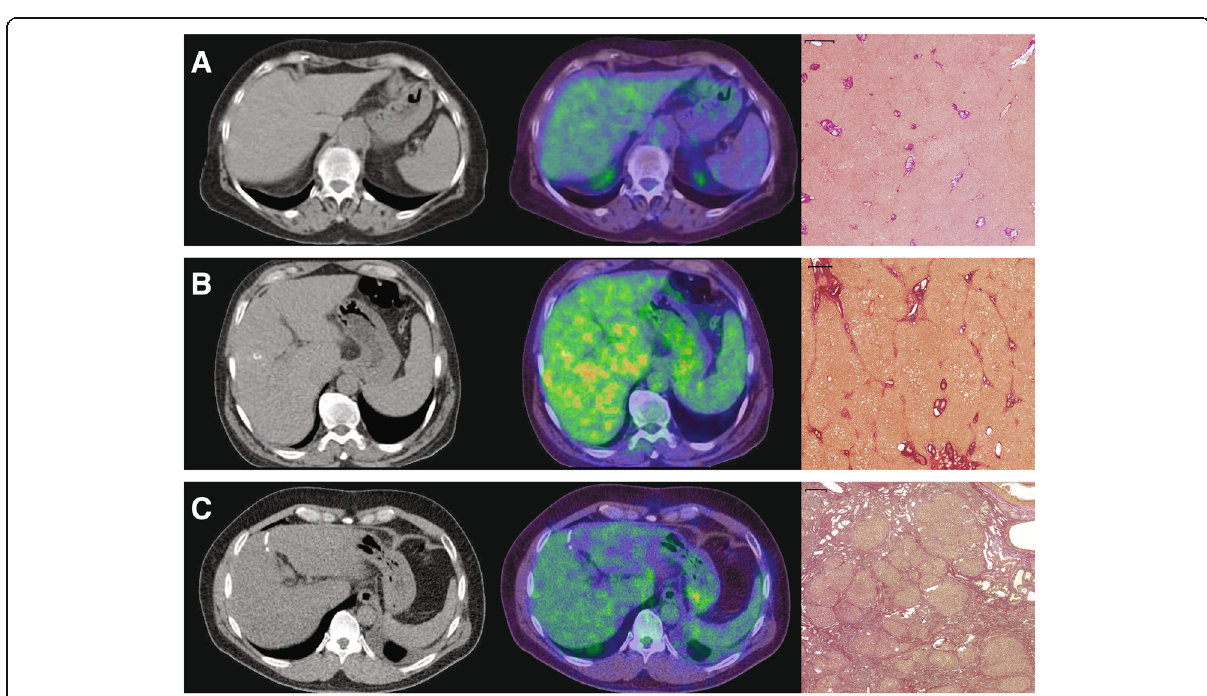
Fig. 4 CT- (left column) and fused PET/CT-images (middle column) of patients with normal liver parenchyma ( a ), advanced liver fibrosis ( b ), and with liver cirrhosis ( c ) with the corresponding histopathology images demonstrating EVG staining (right column). CT images are displayed with the same window (400) and center (40) level. The fused PET/CT-images are shown with an upper SUV threshold of 7.0 using the spectrum color lookup table (SyngoVia) for PET. The scale on histological slices represents 500 μ